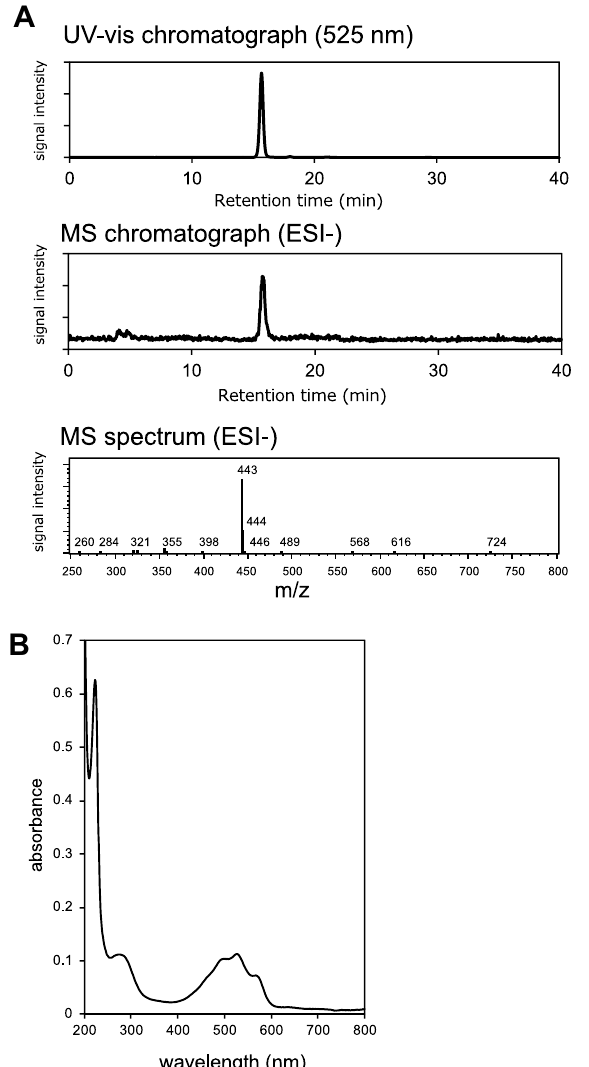
Figure 3. Spectra of the purified catalytic substance. LC–ESI–MS chromatogram ( A ) and UV–vis absorption spectrum ( B ) of the purified active compound. The single peak detected at 15.6 min (panel A , upper) was 443 m/ z in the negative analytical mode according to MS analysis (panel A , lower), which coincided with the [M-H] - m/z of granaticin. The UV–vis absorption spectrum of the purified fraction (panel B ) containing peaks at 220, 285, 490, 525 and 570 nm was identical to the profile of purified granaticin reported by James and Edwards 14